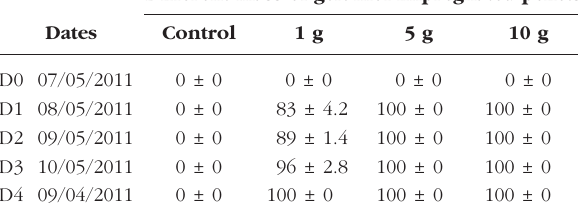
Table III ter. – Experiment B: larval reduction rates (%) of Ae. albopictus in presence of geraniol impregnated pellets, two months after first